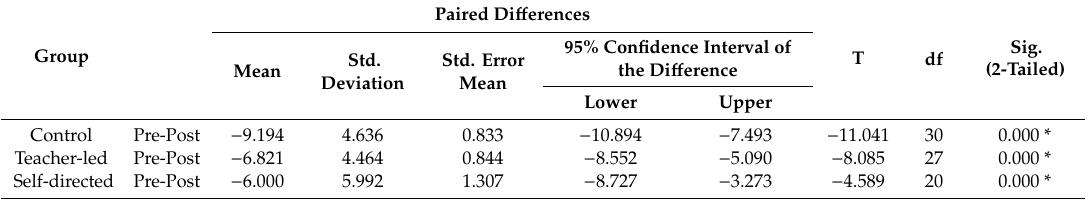
Table 7. Paired-samples t -test on listening performance.